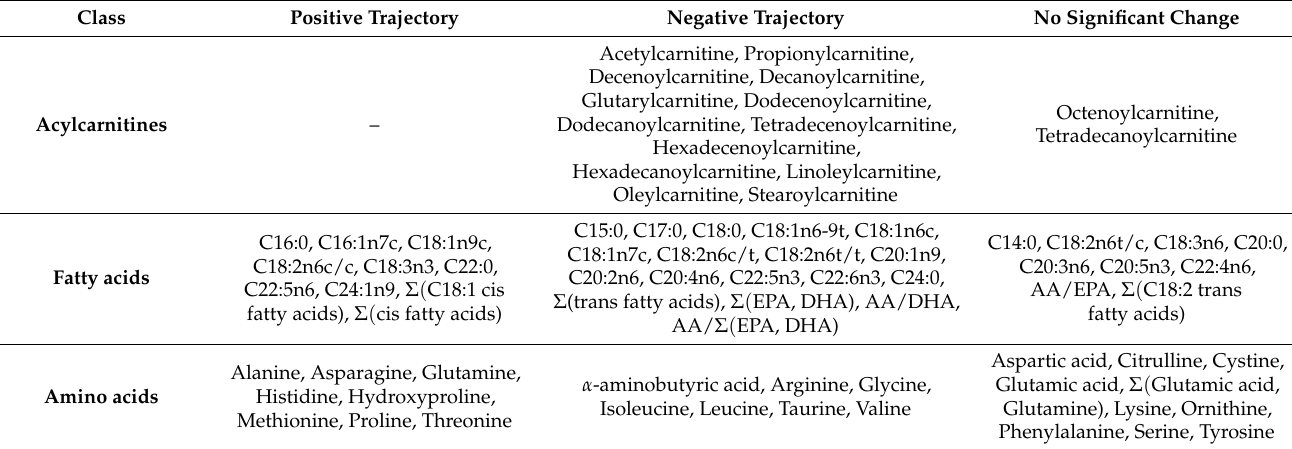
Table 2. Summary of the direction of change for metabolites whose concentrations statistically significantly increased (positive trajectory) or decreased (negative trajectory) over pregnancy (after FDR correction), based on slopes from linear mixed effects models.